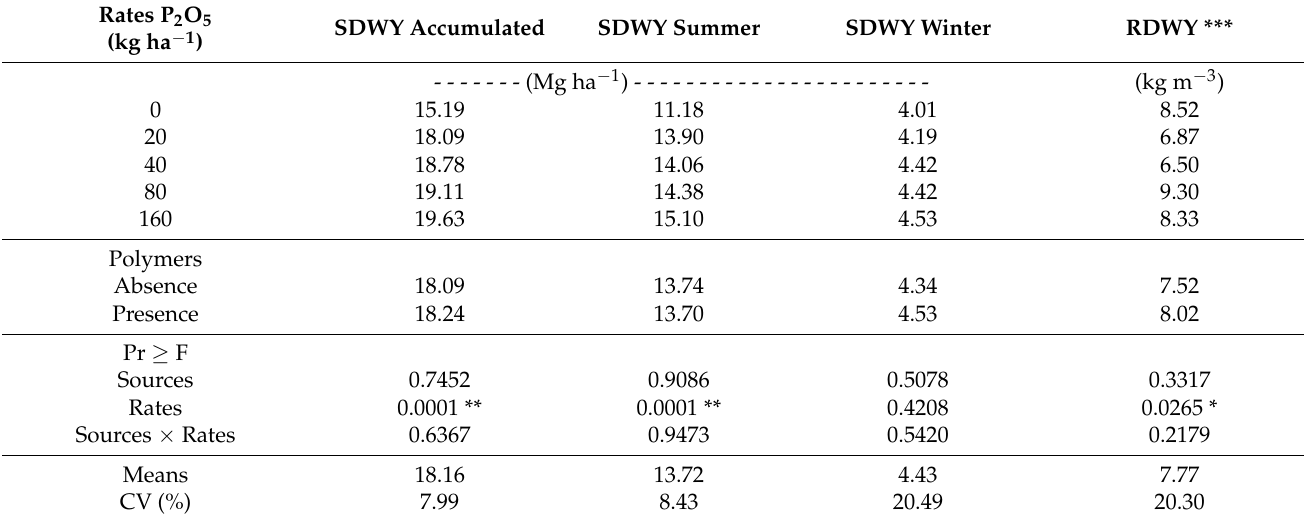
Table 1. Means of accumulated dry weight yield of shoots in the summer, winter, and total seasons, and root dry weight yield of Mavuno grass for different phosphorus sources and rates, in the presence and absence of polymers in dystrophic